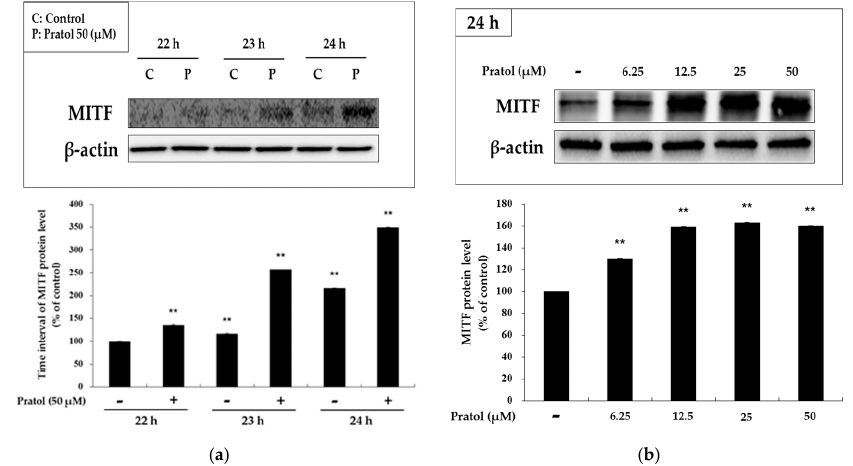
Figure 5. Effect of pratol on MITF expression in B16F10 cells. ( a ) Cells were treated with pratol (50 μ M) at different time intervals; ( b ) Cells were treated with various concentrations of pratol (6.25, 12.5, 25, or 50 μ M) for 24 h. Protein levels were examined by western blotting. Results are expressed as a percentage of the control. The data are presented as mean ± SD of at least three independent experiments. ** indicates p < 0.01.